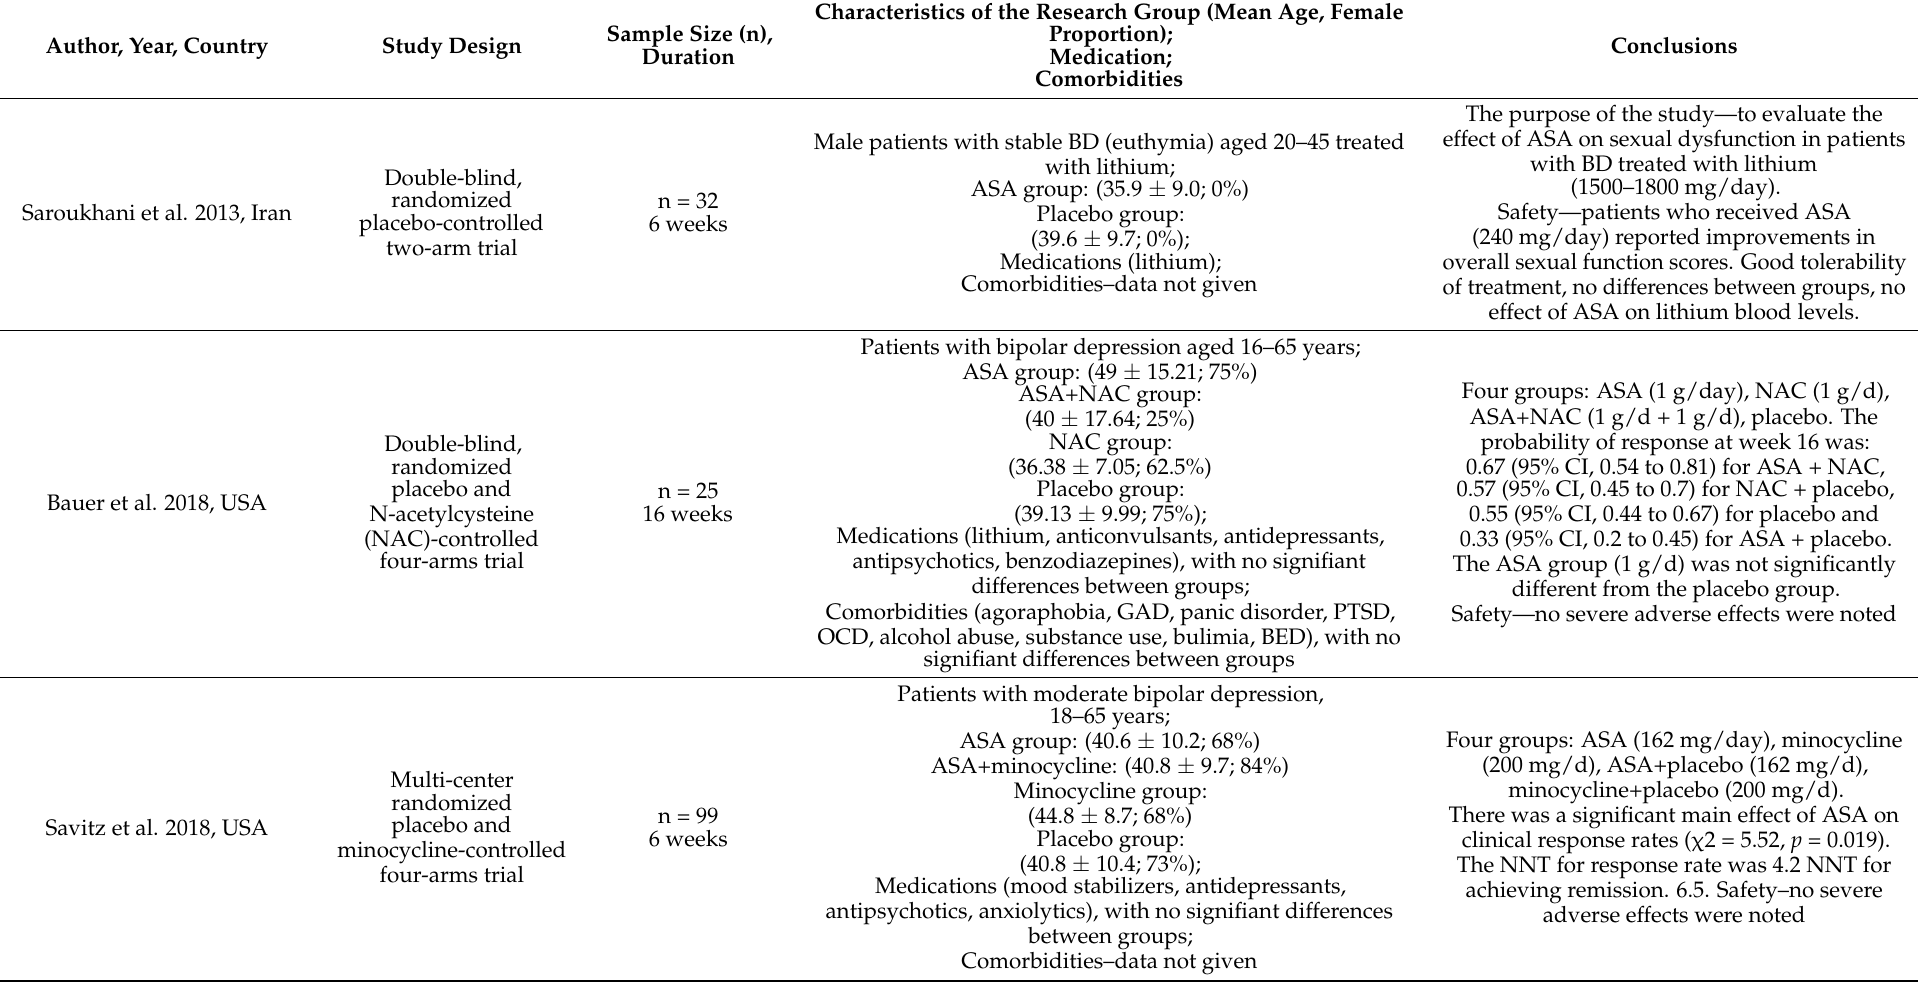
Table 4. Interventional studies with ASA in bipolar disorder and